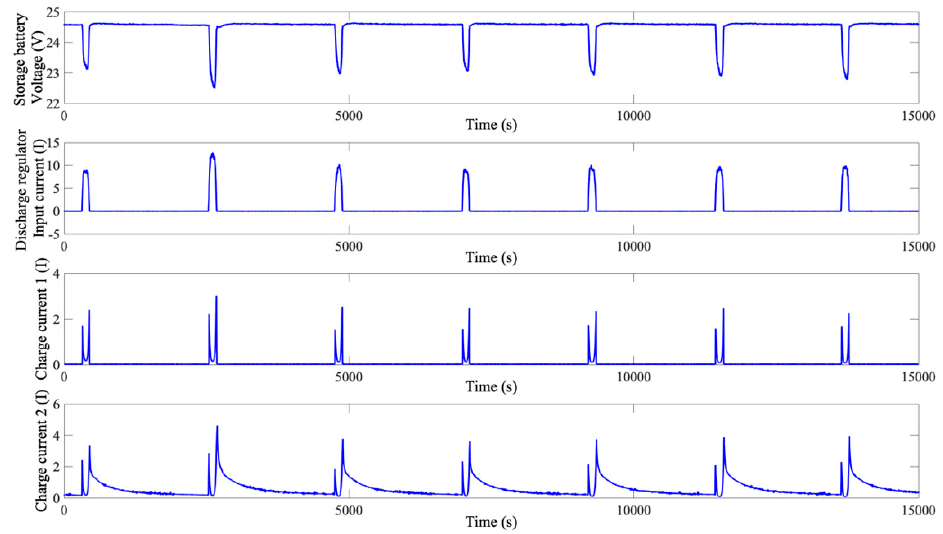
Figure 1. Relationships between the voltage of the storage battery and its current parameters.